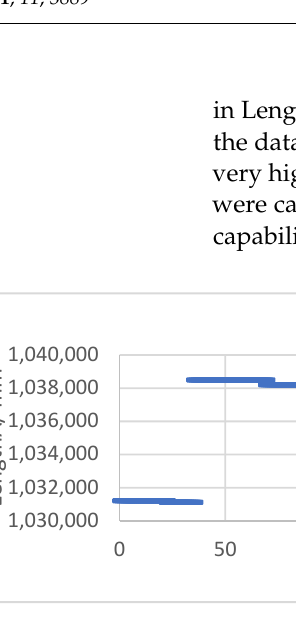
Figure 16. LengthA changes for Tool 3 over number of parts machined. Table 7. Normality and Ppk analysis based on size and LengthA.